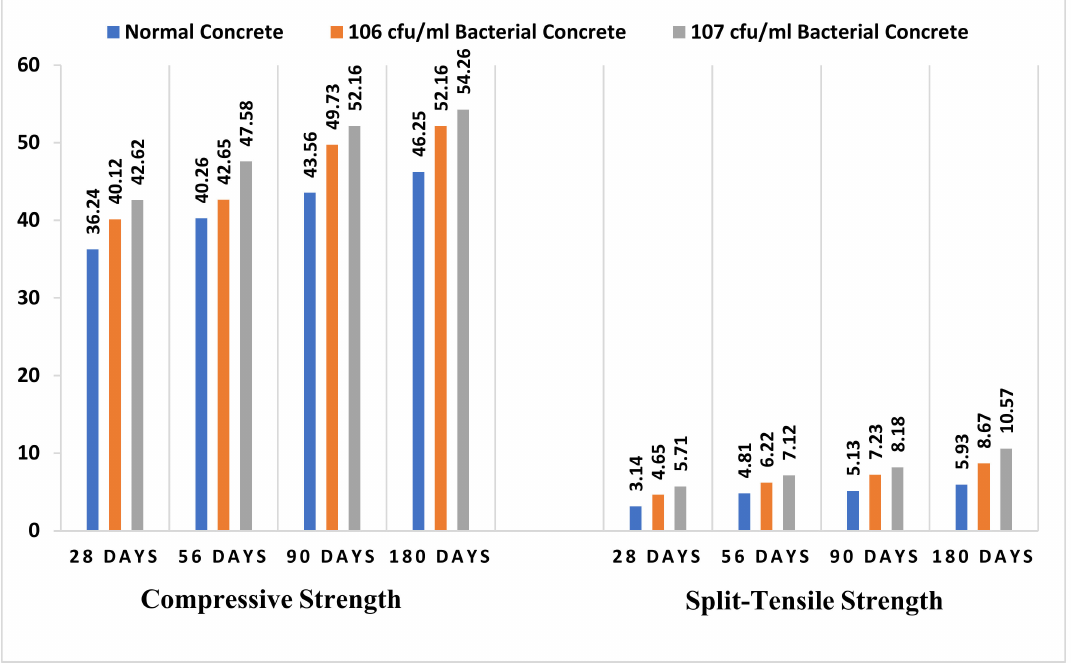
Figure 5. Compressive and tensile